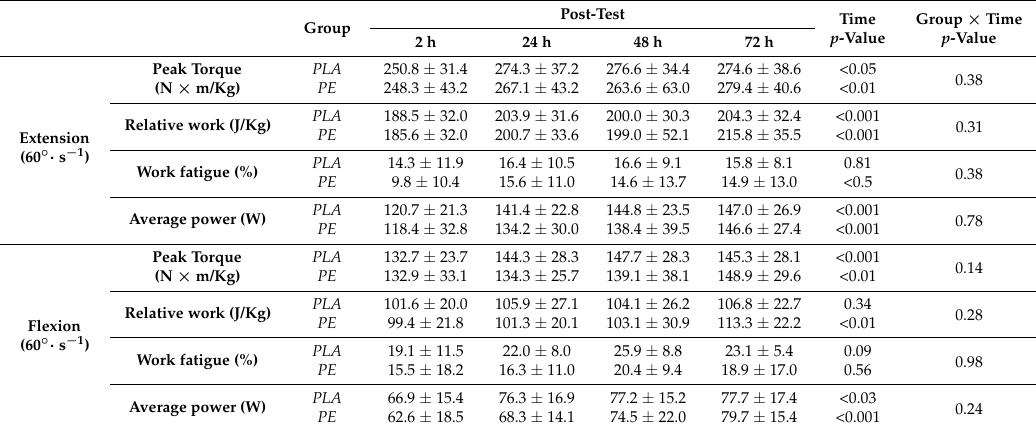
Table 4. Isokinetic test values are presented as means with standard deviation. All units are presented in international units (IU); newton (N), meter (m), kilogram (Kg) and joule (J). For peak torque and work, relative values are given based on the subject’s total weight. Post-Test Time Group × Time Group p -Value p -Value2 h 24 h 48